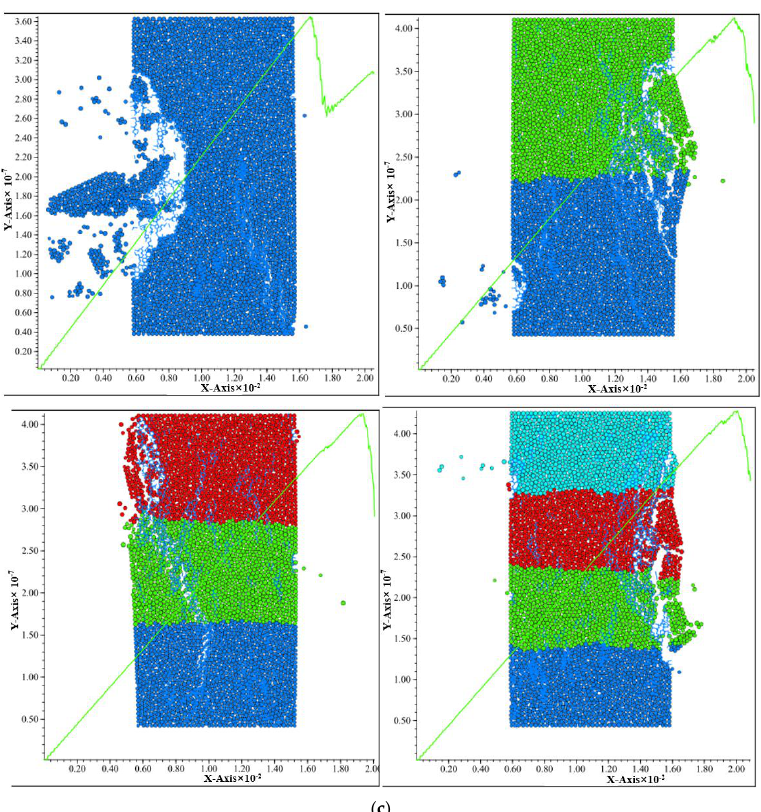
Figure 16. Simulation of the fracture morphology of the sample block of backfilling body: ( a ) Packing concentration 66%; ( b ) Packing concentration 68%; ( c ) Packing concentration 70%. At the initial stage of the stress-strain curve of the layered backfill body, the contact force be- tween particles is less than the strength of the bond between particles, the bond between particles is not damaged, and no cracks occur in the layered backfill body. With the loading process, the contact force between particles increases gradually and begins to exceed the bond strength. The bond strength is destroyed, and internal cracks begin to occur, and the crack increment curve begins to fluctuate. When the load continued to be applied, more and more contact forces between particles exceeded the bonding bond strength, and more bonding bonds were destroyed. At this time, internal cracks began to increase, and the increment curve of cracks rose slowly. When the external load gradually reached 80% of uniaxial compressive strength, the cumulative crack curve showed inflec- tion point and increased rapidly, and the increment crack curve also jumped. When the load con- tinued to be applied, the stress-strain curve began to decline, the crack accumulation curve contin- ued to grow at a high speed, and the crack increment curve remained stable at a high level. Because the two parameters of PFC2D software model, porosity and friction coefficient between particles, are parameters that cannot be obtained in laboratory tests, they can only be roughly judged based on the experience of repeated tests and previous research, so some unavoidable error values will appear. Comparing the model obtained by the software with the failure mode of the laboratory block in Figure 15, it shows the through tensile failure and half through shear failure parallel to the loading direction. The whole backfill specimen shows tensile failure, but at the same time it shows